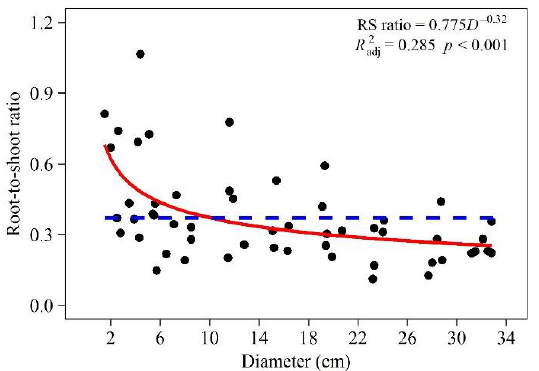
Figure 4. Root-to-shoot ratio against diameter ( n = 53). The red line represents the fitted power function, and the blue short dashed line represents the mean value of the root-to-shoot